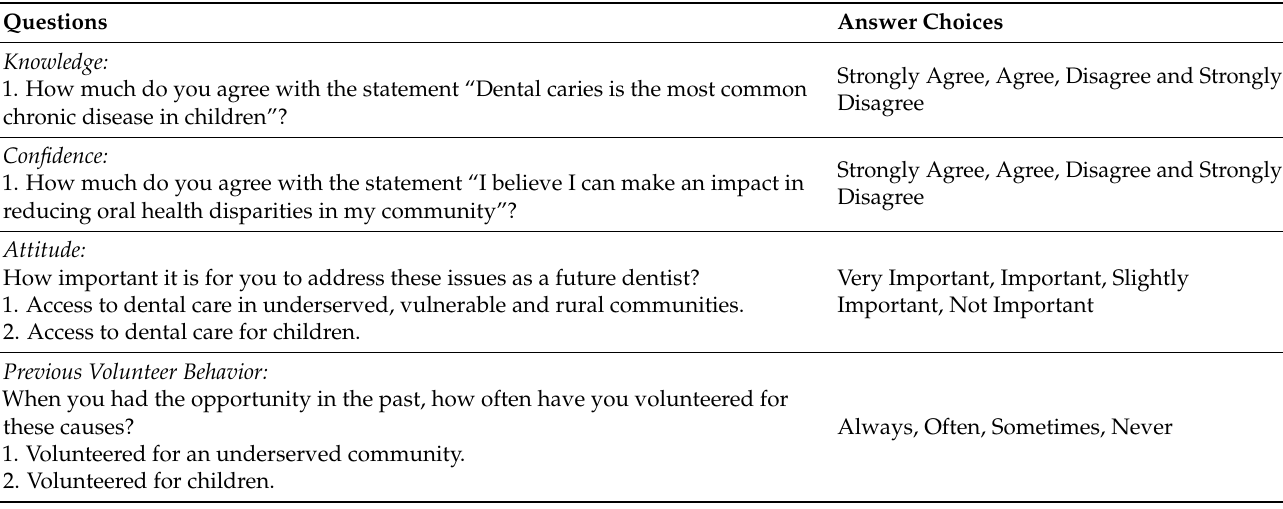
Table 1. Questions Related to Knowledge, Confidence, Attitude and Previous Volunteer